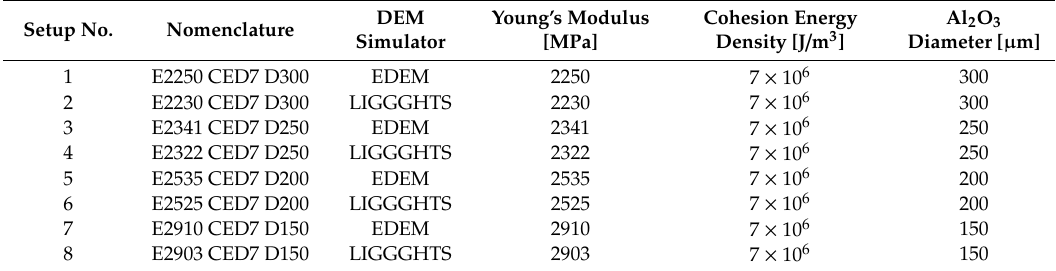
Table 5. Setups used for the validation of the DEM